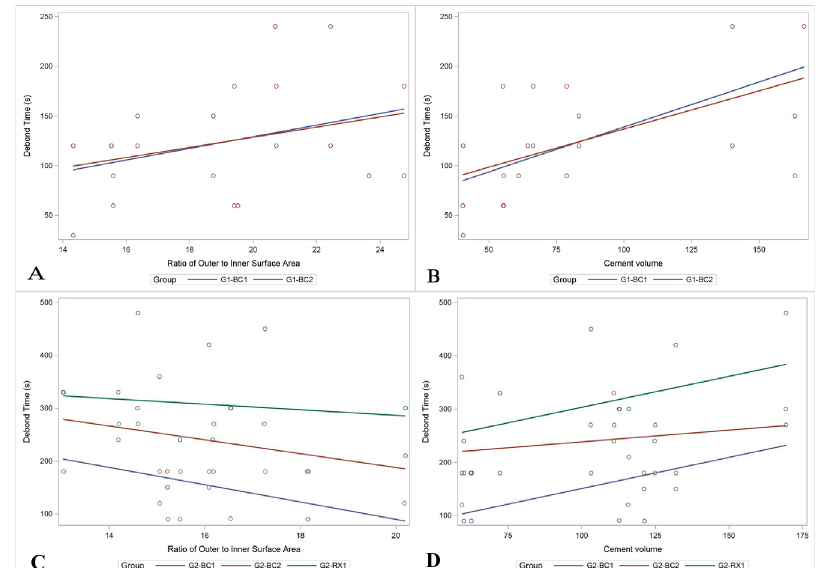
Figure 2. Correlations of debond time with ratio of outer to inner surface area ( A , C ) and cement volume ( B , D ) for primary ( A , B ) and permanent ( C , D ) teeth. Table 2. Pairwise correlations between crown metrics and time to debond.